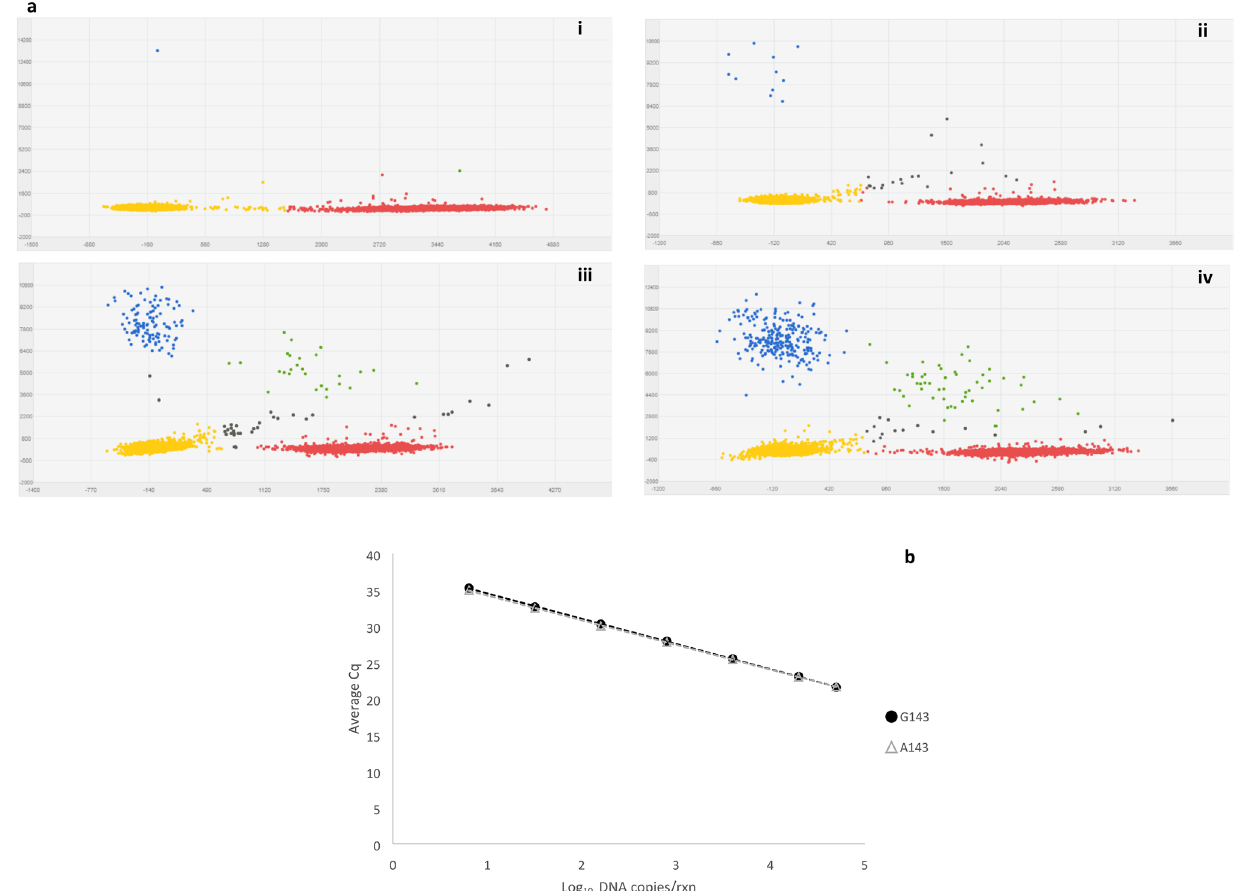
Figure 2. Sensitivity and specificity of the dPCR and ASqPCR assays targeting the cytb G143A. ( a ) Scatter plots for Blumeria graminis f. sp tritici ( Bgt ) G143A dPCR assay using known ratios of genomic DNA for the strobilurin resistant Bgt sample Geelong 1 (A143 allele) and sensitive Bgt sample Goomalling (G143 allele). Scatter plots were prepared with Quantstudio 3D AnalysisSuite. Wells with the A143 allele are represented by blue signals (FAM), G143 alleles are represented by red signals (VIC), detection of both alleles are represented by green signals, wells without any alleles (passive reference) are represented by yellow signals (ROX) and outliers represented by grey signals. (i) 100% Goomalling gDNA (G143 allele only); A143 frequency = 0.04%. (ii) 0.33% Geelong1 gDNA; A143 frequency = 0.23%. (iii) 3.39% Geelong 1 gDNA; A143 frequency = 3.10%. (iv) 6.90% Geelong 1 gDNA; A143 frequency = 7.87%. ( b ) Correlation of threshold cycle in ASqPCR and amount of DNA of either G143 (R 2 = 0.9998) or A143 (R 2 = 0.9999) alleles,